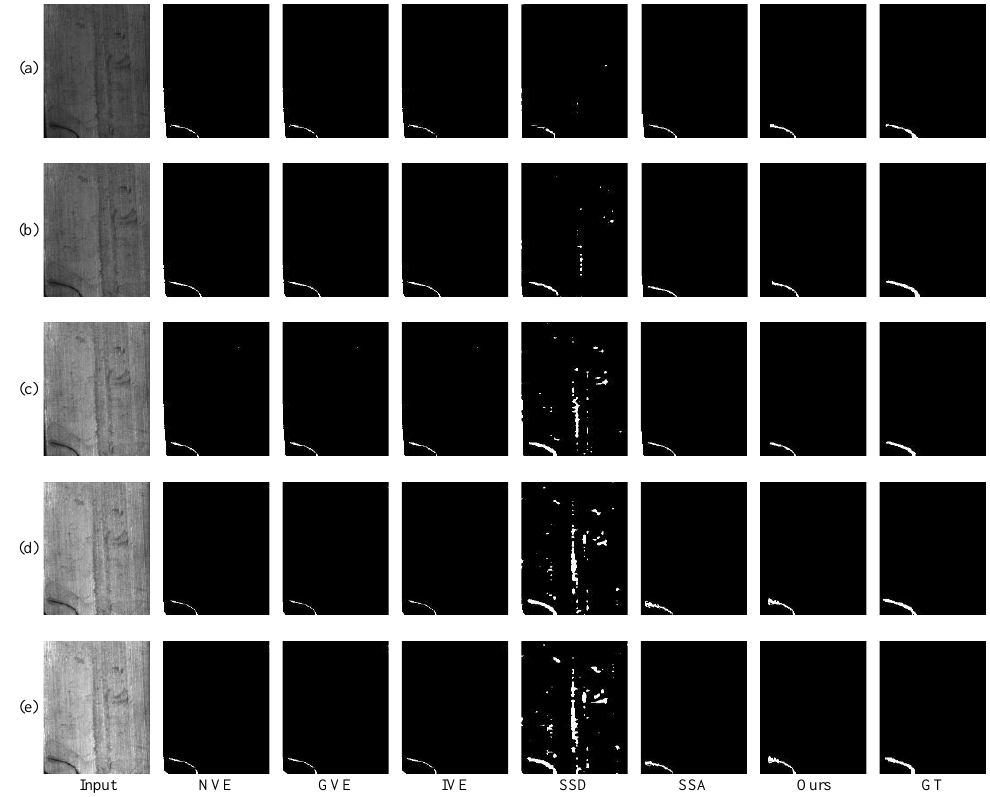
Figure 5. Visual comparisons of six methods on ( a – e ) five randomly selected crack defect images. NVE, GVE, IVE, SSA, and our method are all close to ground